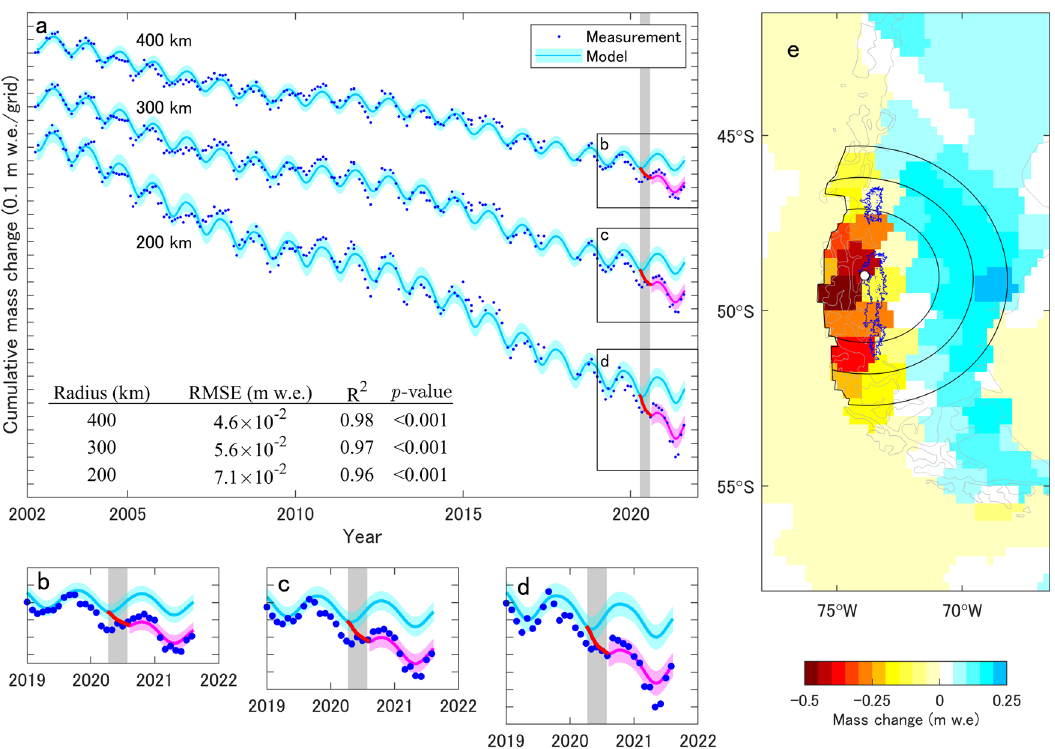
Fig. 5 Mass changes over the study region. a Mass changes in the GRACE mascon solution summed over areas within 200, 300, and 400 km from the lake. Cyan curves are the best- fi t time series assuming Eq. 2. RMSEs of the model are shown by the shading around the curves. Red and magenta curves are results of the regression assuming an additional mass loss event that occurred at a constant rate from 8 April to 29 July 2020 (gray shaded band). RMSEs, correlation coef fi cients, p -values of the fi tting are also shown. b – d shows the close-up view of the parts after 2019. e Distribution of mass changes from March to August, 2020. Regions within blue curves indicate the Patagonia Ice fi elds. The white dot indicates the location of Lago Greve. Solid curves indicate the regions within 200, 300, 400km from the